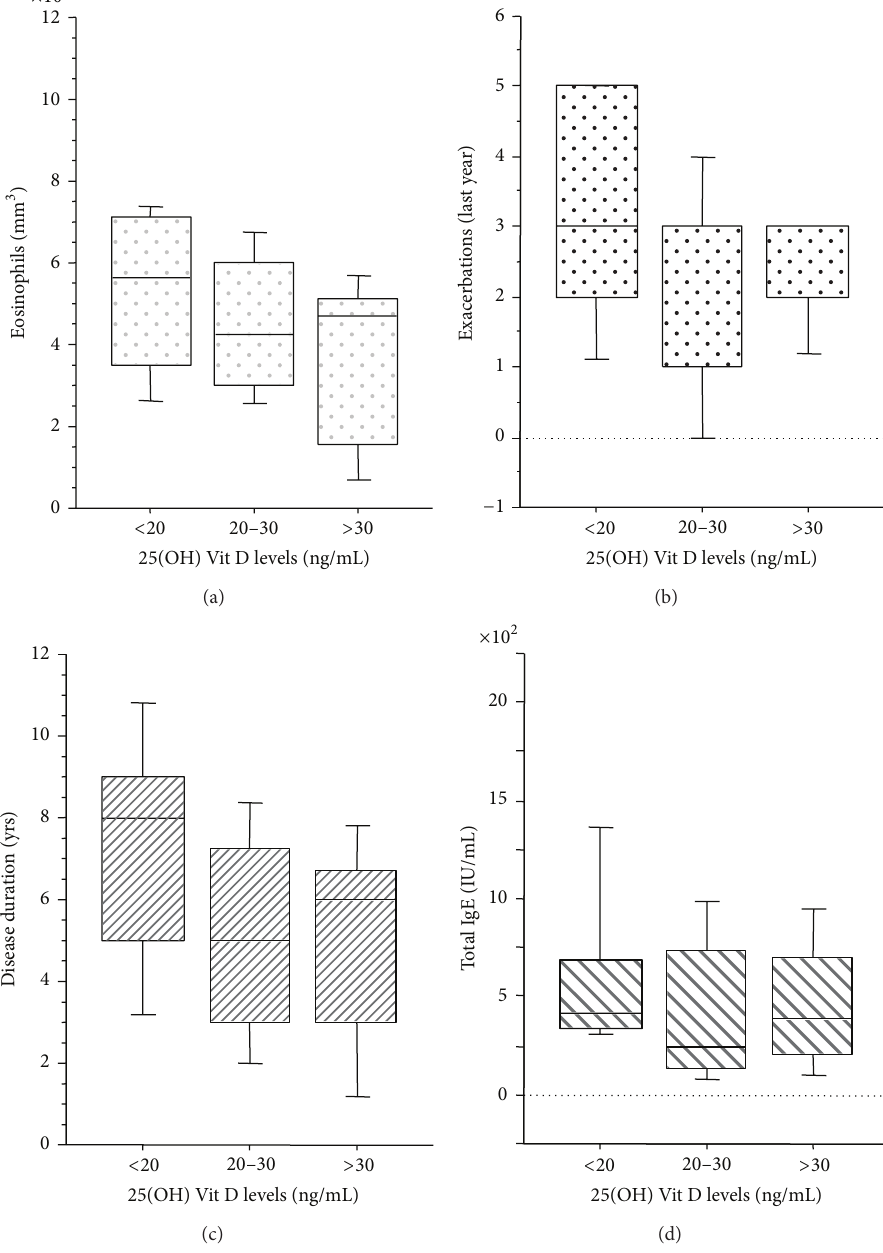
Figure 4: Asthma control parameters and 25(OH) Vit D status in patients with AAR ( 𝑛 = 35 ). (a) Blood eosinophils (number/mm 3 ), (b) exacerbations (number/last year), (c) disease duration (yrs), and (d) total IgE (IU/mL) in AAR patients with deficient ( 𝑛 = 6 ), insufficient ( 𝑛 = 22 ), or sufficient ( 𝑛 = 7 ) 25(OH) Vit D levels. Bars in the box plots indicate (from the bottom to the top) 10th, 25th, 50th (median), 75th, and 90th percentiles. Statistical analysis was performed by Kruskal-Wallis test. Significance was accepted at 𝑃 < 0.05 .